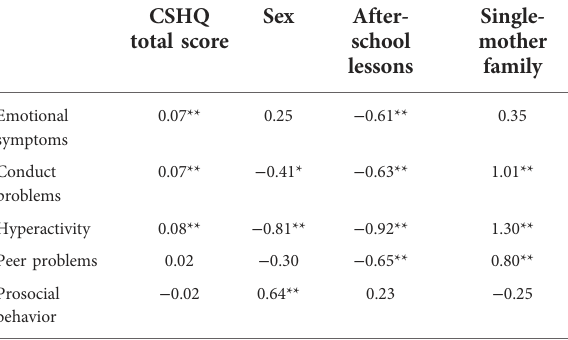
TABLE 7 Effect of the four factors on SDQ subscale scores (CSHQ total score, sex, after-school lessons, and single-mother